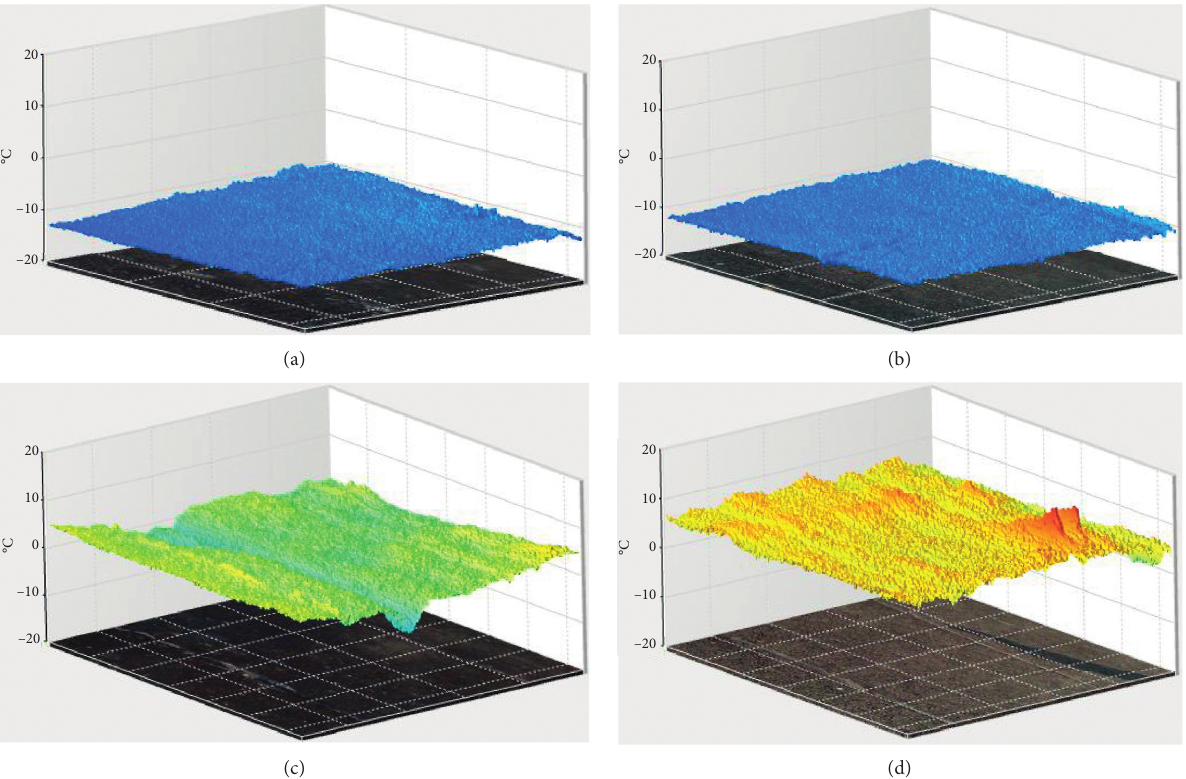
Figure 5: The IRT of the asphalt pavement surface. (a) Initial time (1# asphalt pavement). (b) Initial time (2# asphalt pavement). (c) 150 minutes (1# asphalt pavement). (d) 150 minutes (2# asphalt